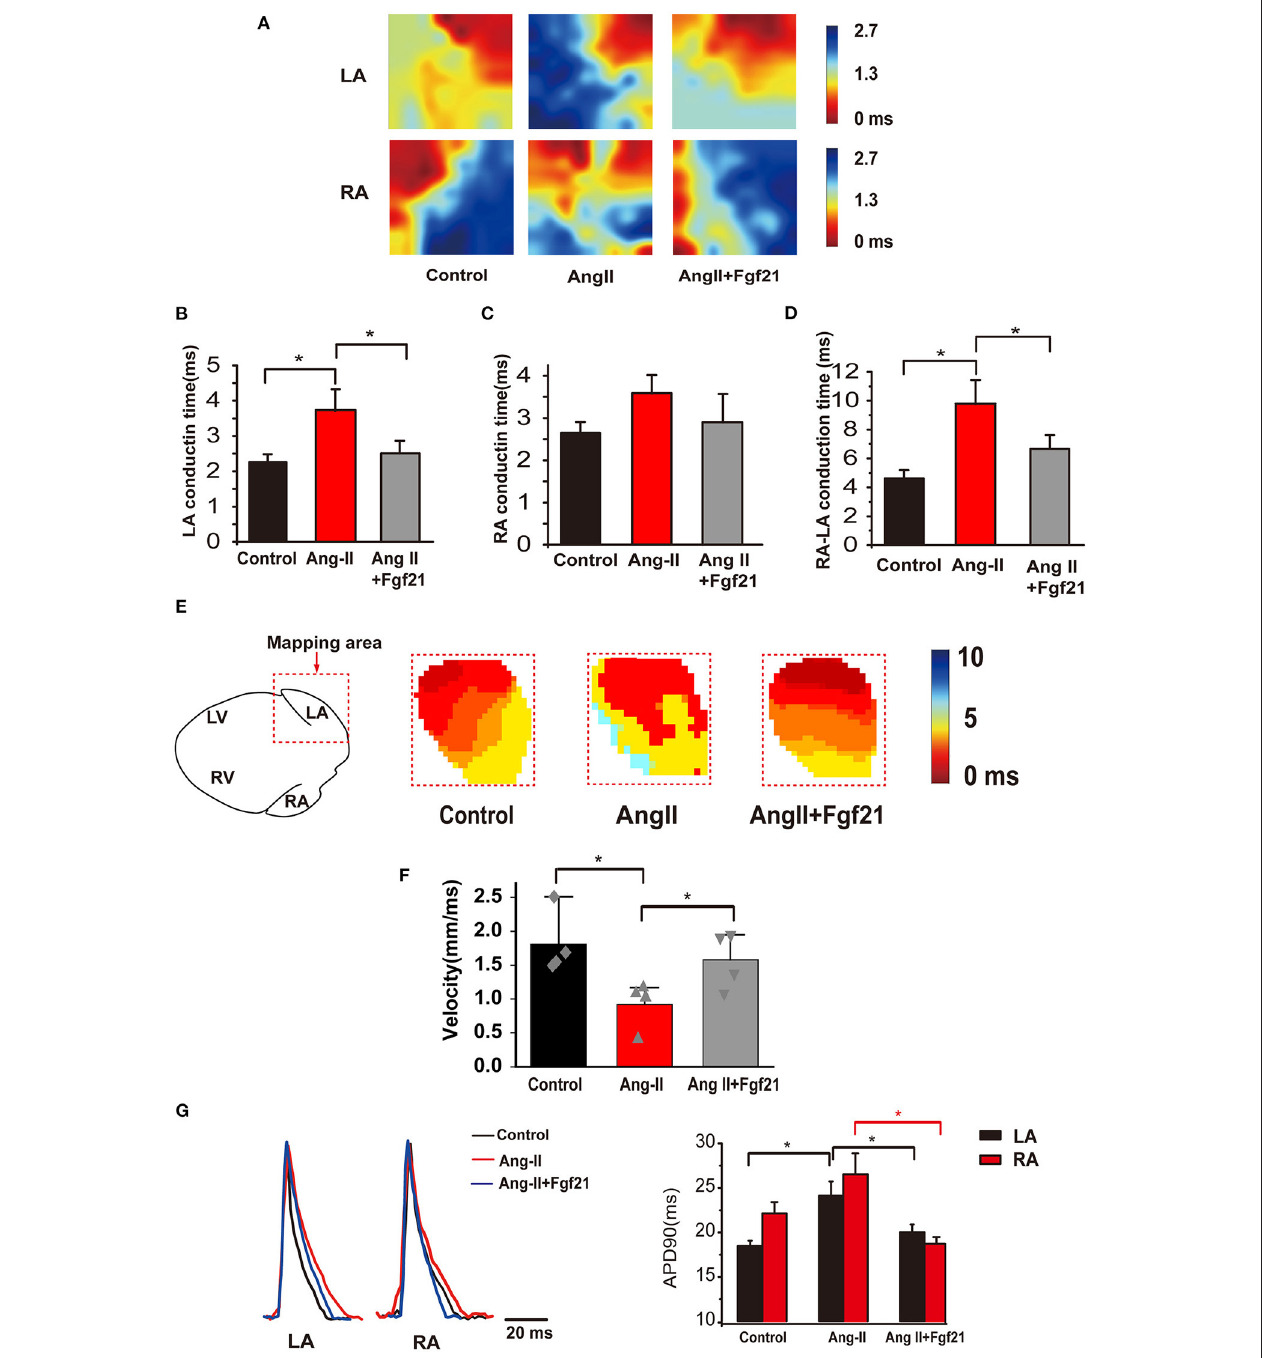
FIGURE 3 | Atrial electrical conduction properties in Ang II mice with or without treatment of Fgf21. (A) Representative activation maps from electrical mapping in isolated atrial preparations from each group of mice. Red color indicates the earliest activation time and the blue color indicates the latest activation time. (B,C) Summary of the right and left atrial conduction time in sinus rhythm. (D) Summary of the conduction time of the right atria to the left atria in sinus rhythm. (E) Representative activation maps of the left atria from optical mapping from each group of mice. Red color indicates the earliest activation time and the blue color indicates the latest activation time. (F) Summary of the conduction velocity of the left atria in sinus rhythm. (G) Representative traces of optical action potentials by optical mapping in atria from each group mouse. Summary of the mean APD90 of mice hearts from each group. * p < 0.05, n = 6 mice per group.